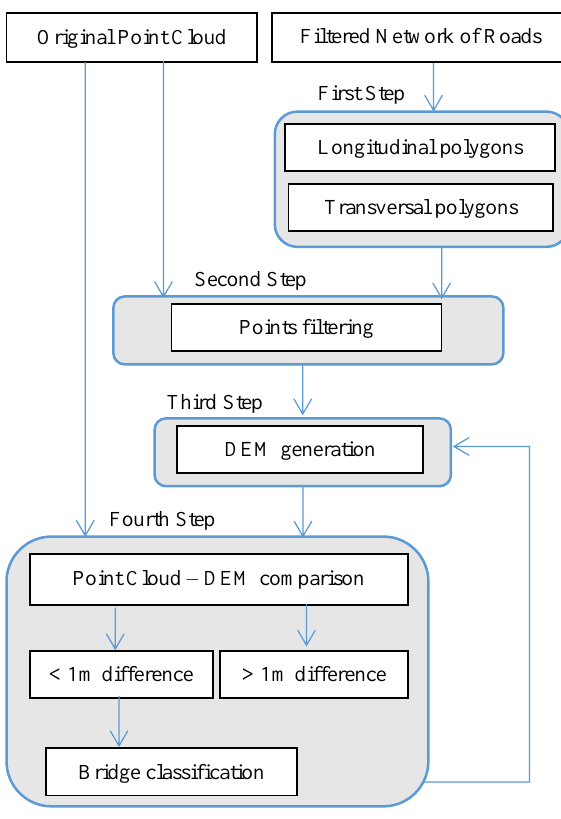
Figure 2 – Bridge classification flow chart Three loops are implemented to obtain satisfactory results where bridge points are discriminated against ground and building ones.